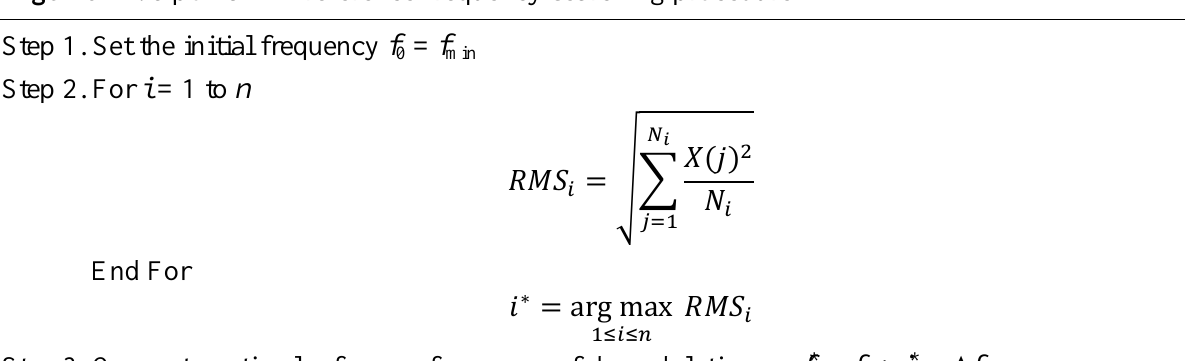
Algorithm : Optimal AE reference frequency searching